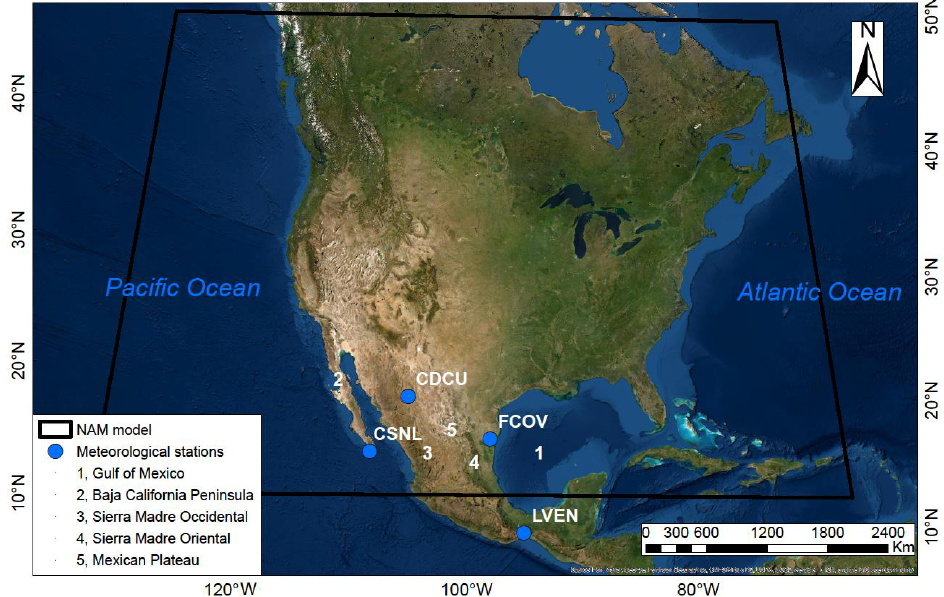
Figure 1. Weather stations and masts (blue dots) used in the study and North American Forecast System (NAM) domain (black line). Cabo San Lucas (CSNL), Ciudad Cuauhtemoc (CDCU), Francisco Villa (FCOV), and La Venta